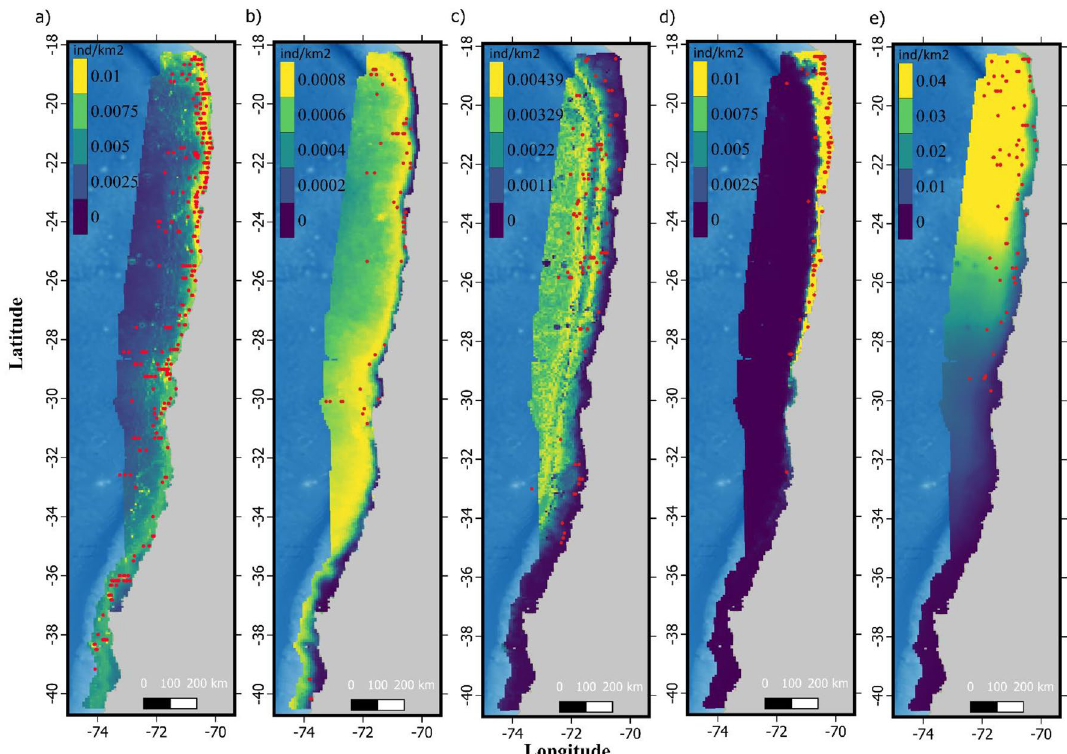
Figure 3. Predicted distribution for ( a ) fin whale, ( b ) blue whale, ( c ) sperm whale, ( d ) dusky dolphin and ( e ) common dolphins considering results from the Binomial N-mixture model. Data layers (including maps) were created in R ver. 4.0.2 (www.r- proje ct. org) and ensembled in QGIS ver. 3.8.0 (www. qgis. org) for final rendering. Maps were created using data on bedrock topography from the National Centers for Environmental Information (https:// maps. ngdc. noaa. gov/ viewe rs/ grid- extra ct/ index. html). Grid-cells with values above 0 were considered land coverage and assigned a uniform